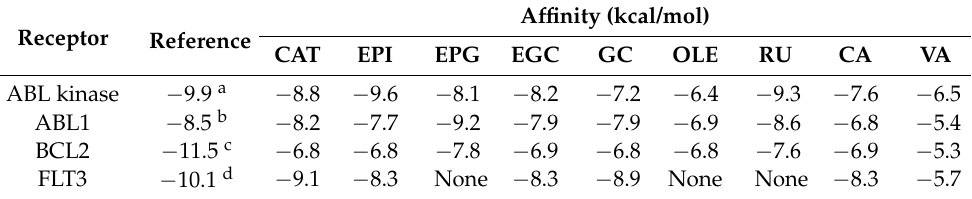
Table 5. Docking results for different ligands and reference molecules with the